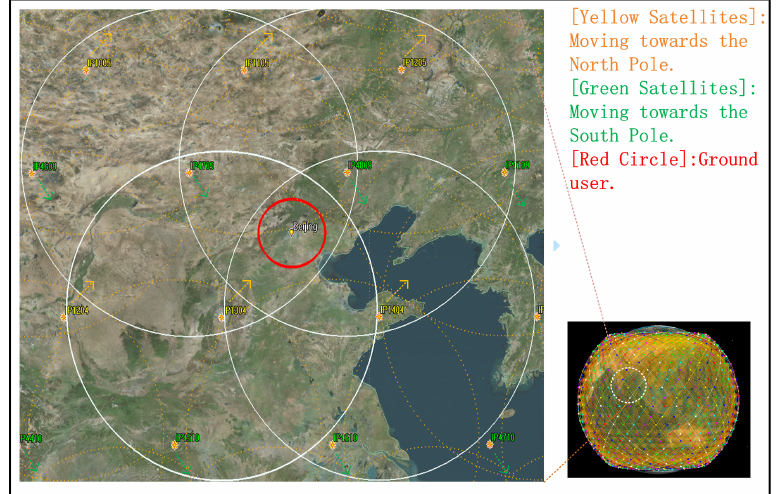
Figure 1. Walker-delta constellation schematic.